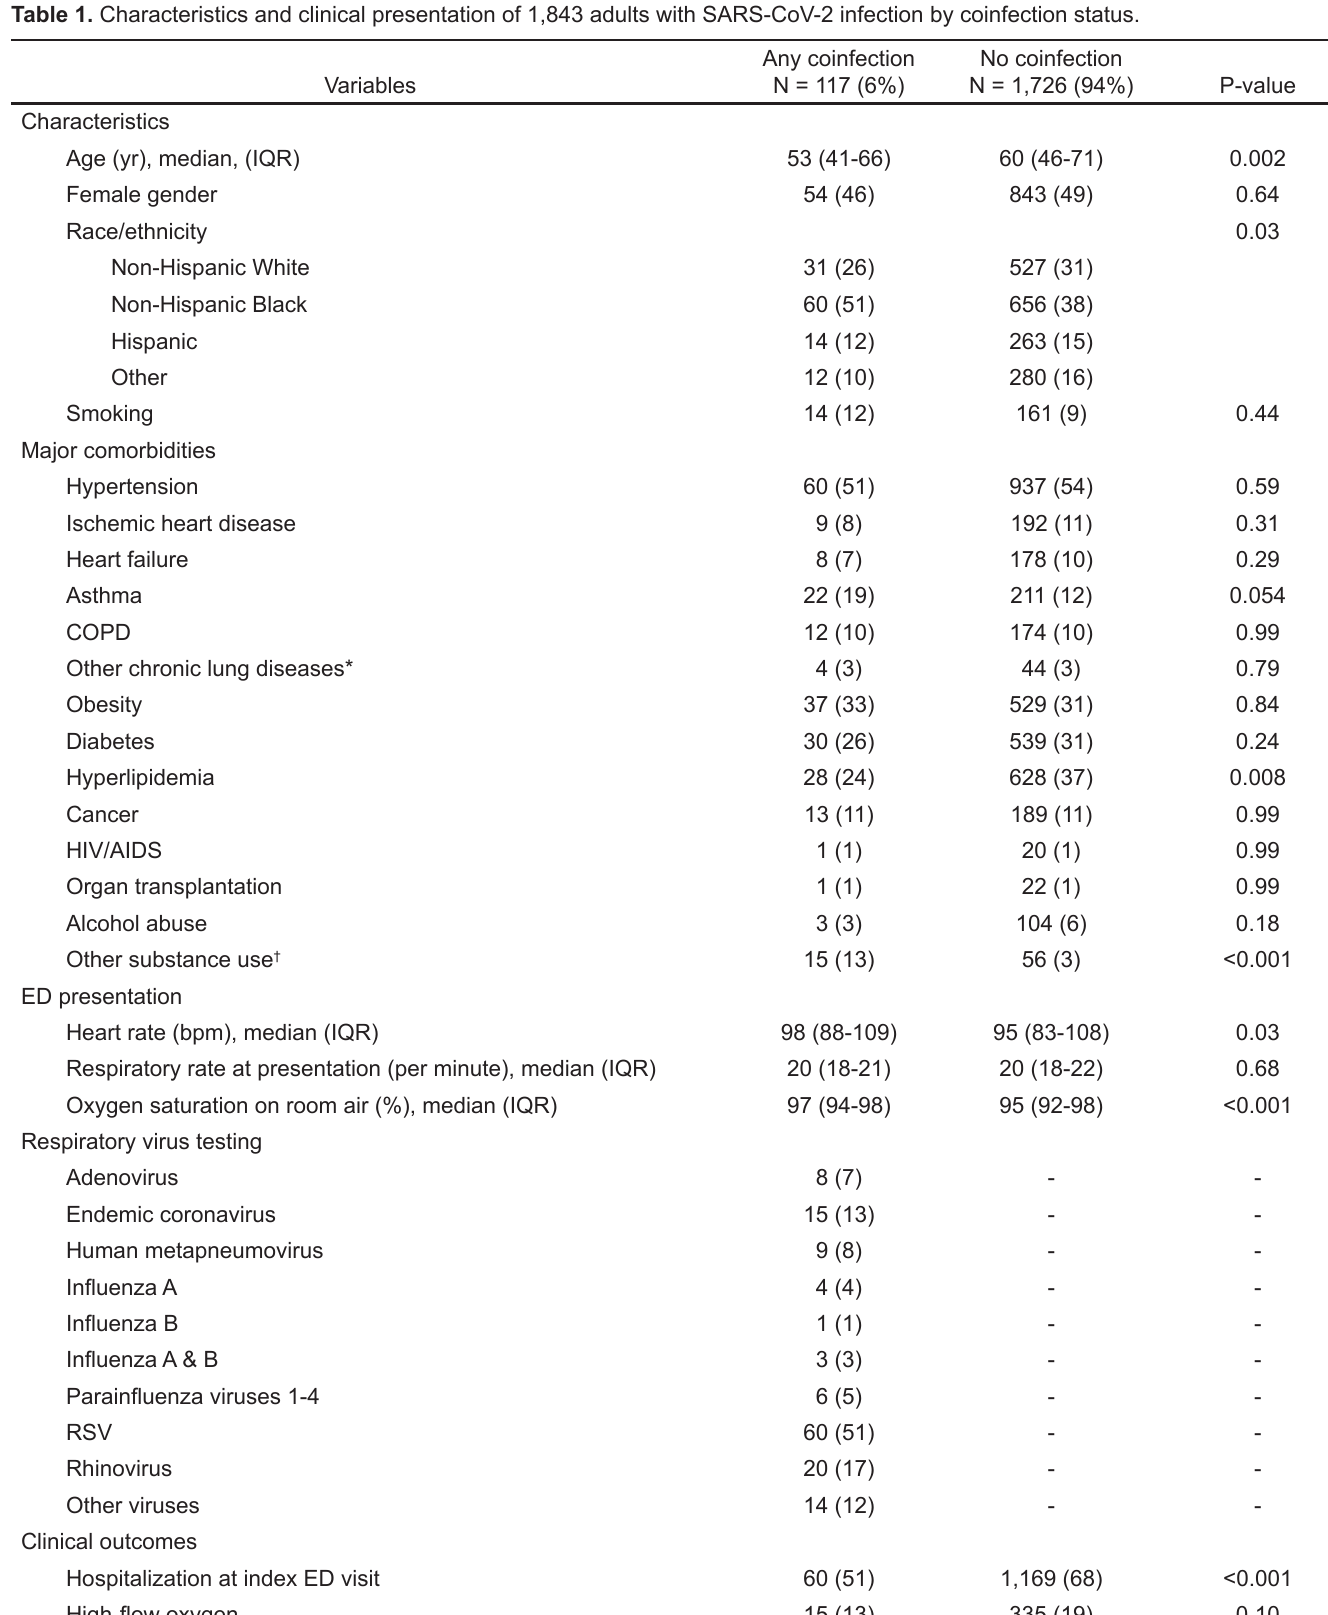
Table 1. Characteristics and clinical presentation of 1,843 adults with SARS-CoV-2 infection by coinfection